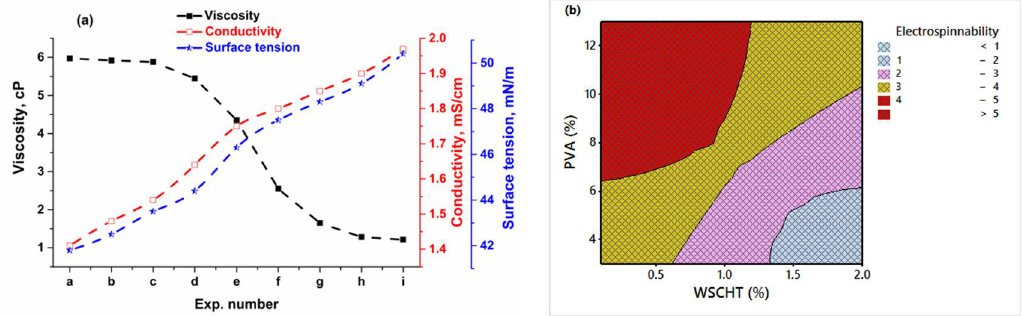
Figure 4. ( a ) Physical properties and ( b ) Contour plot the spinnabilities of W S CHT vs. Poly(vinyl alcohol) (PVA) solution.